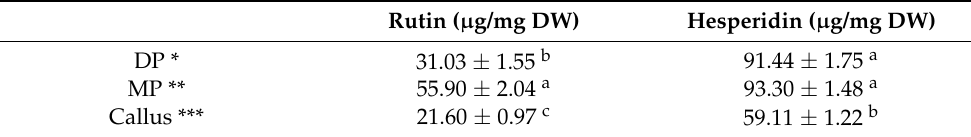
Table 7. Rutin and hesperidin content ( µ g/mg DW) in methanol extracts of R. chalepensis .